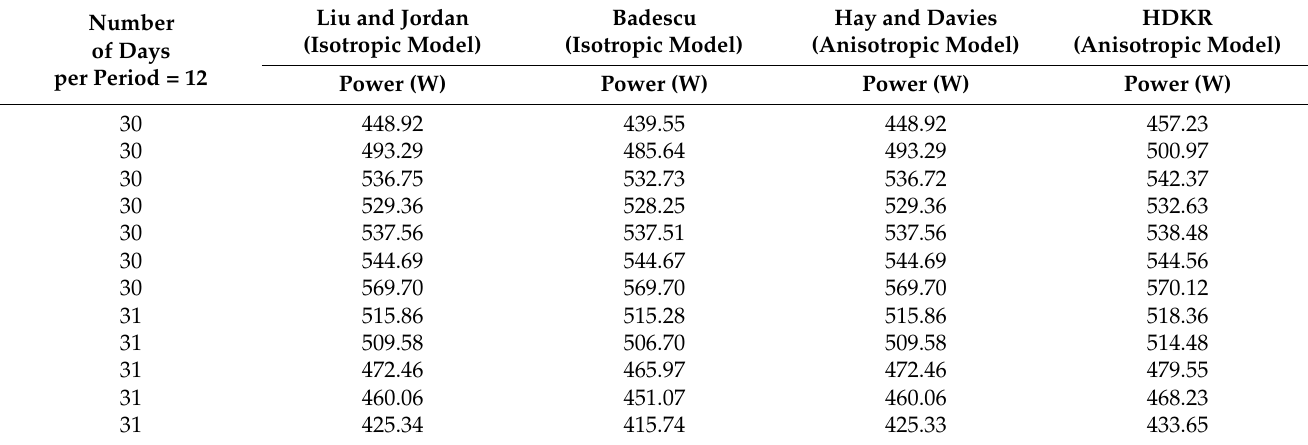
Table 8. Power results for Makkah city for NP = 12.